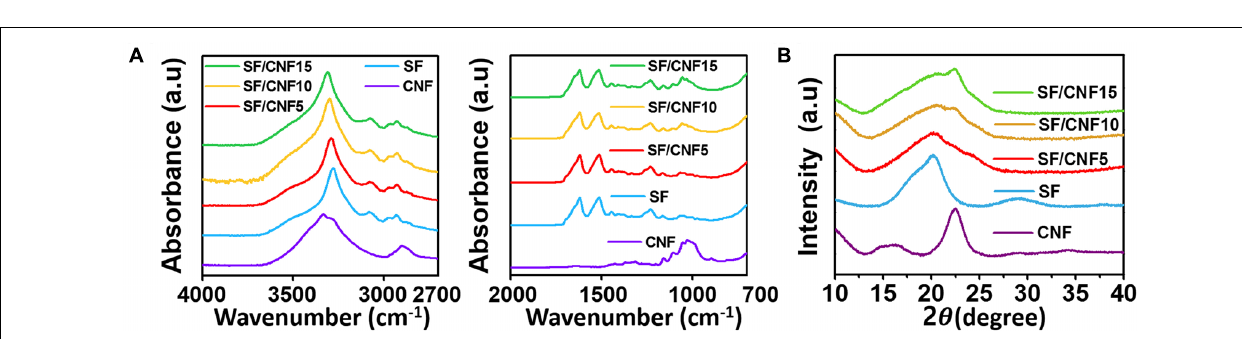
β -sheet structure of the SF, even when CNF is added, will